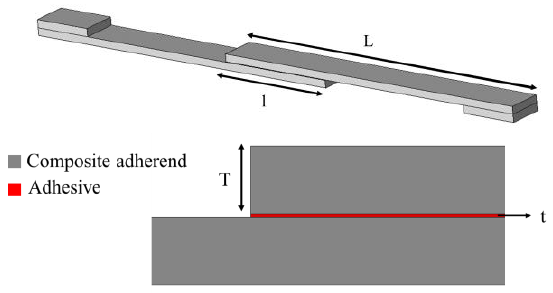
Figure 2. Schematic design of a single lap joint.